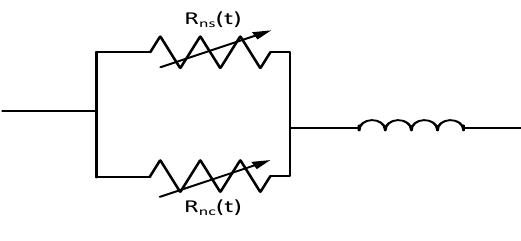
Figure 5. A simple structure of resistive SFCL.